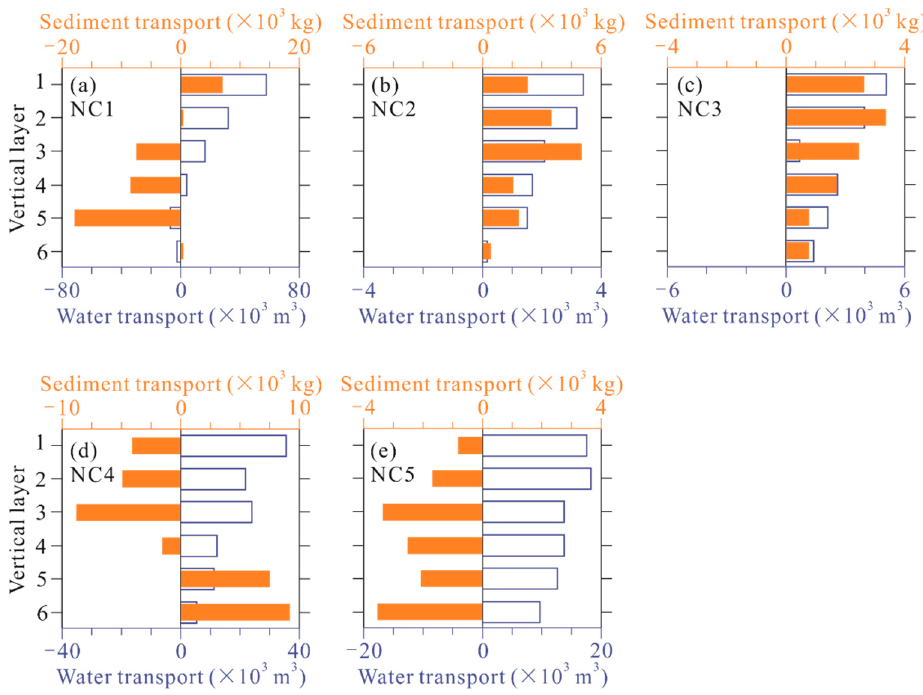
Figure 10. Longitudinal net water transports per unit width, Tr w (hollow bars, unit: × 10 3 m 3 ), and longitudinal net sediment transports per unit width, Tr sed (filled bars, unit: × 10 3 kg), over a flood-ebb tidal cycle on six layers of NC1 to NC5 stations ( a – e ).